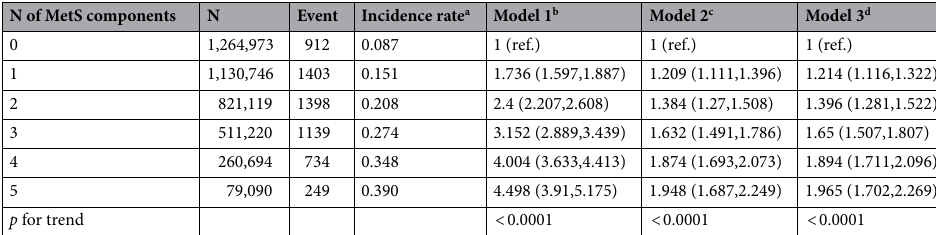
Table 3. Incidence probability of ocular motor cranial nerve palsy up to 8 years according to the number of metabolic syndrome components. N number, MetS metabolic syndrome. a Ocular motor cranial nerve palsy incidence per 1,000 person-years. b Model 1 was unadjusted. c Model 2 was adjusted for age and sex. d Model 3 was adjusted for age, sex, smoking status, alcohol consumption, and physical